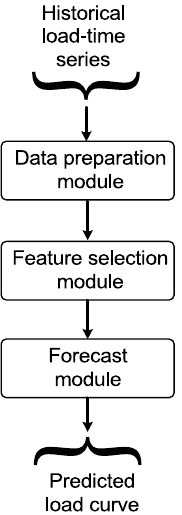
Figure 2. Block diagram of the proposed